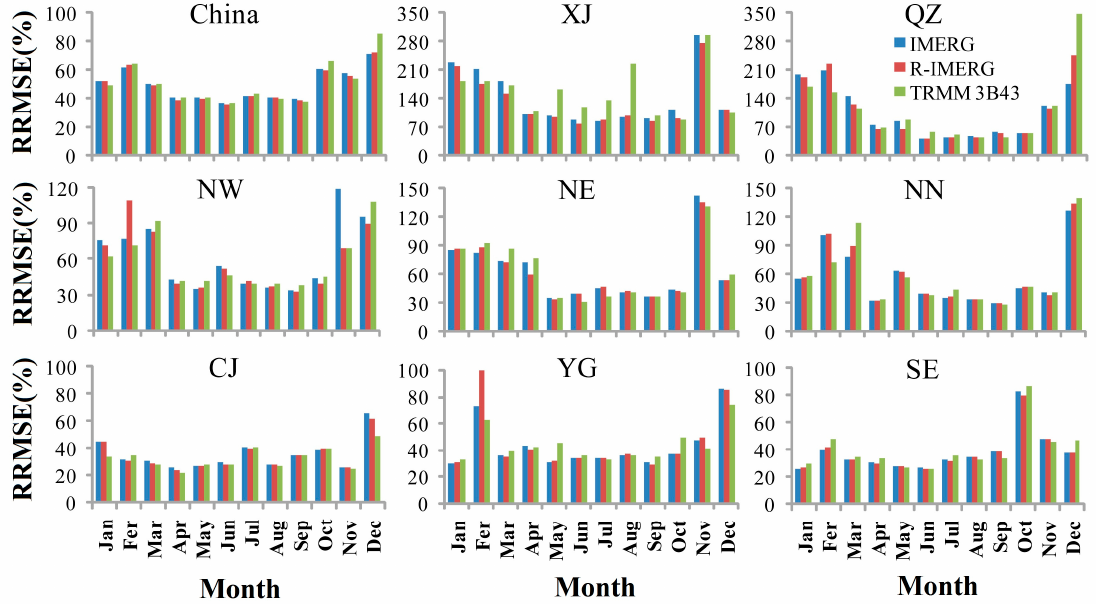
Figure 9. RRMSE values of monthly precipitation estimates derived from IMERG, R-IMERG, and TRMM 3B43 products over Mainland China and its eight sub-regions.